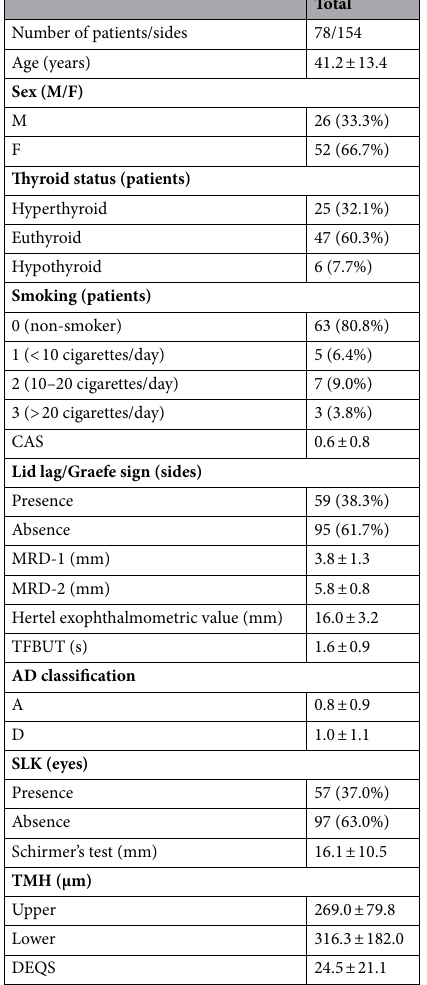
Table 1. Patient data. M male, F female, CAS clinical activity score, MRD margin reflex distance, TFBUT tear film break-up time, SLK superior limbic keratoconjunctivitis, TMH tear meniscus height, DEQS dry eye- related quality-of-life